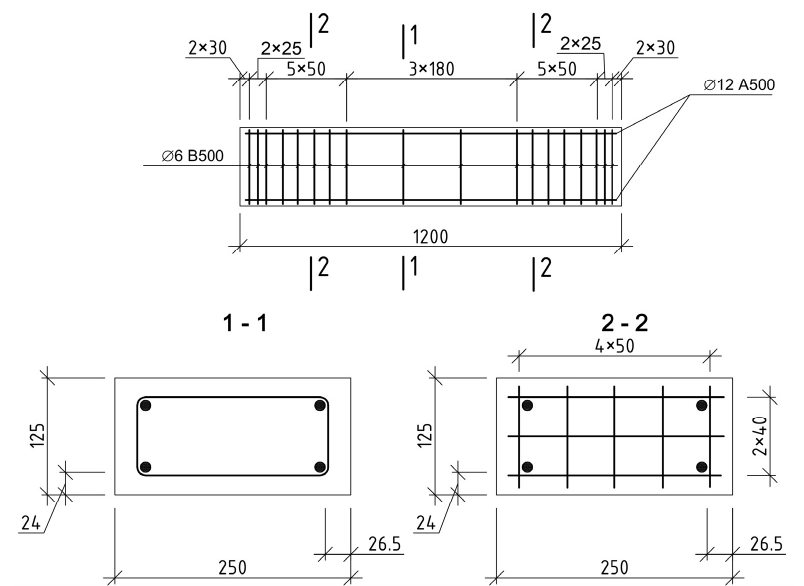
Figure 1. Design of frames of prototypes.